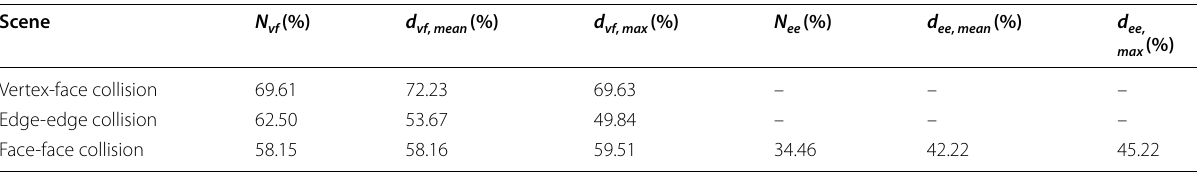
Table 2 Quantitative evaluation of collision